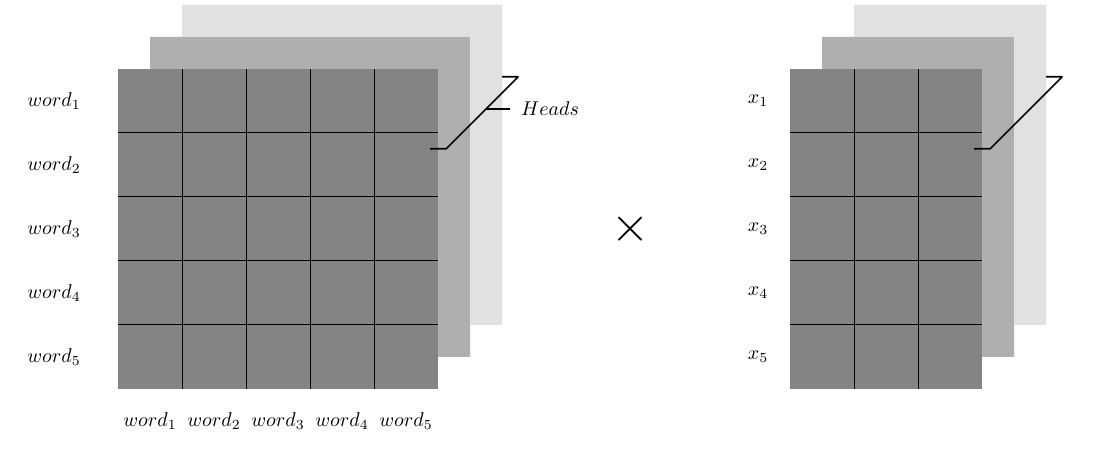
Figure 2. Self attention mechanism on word